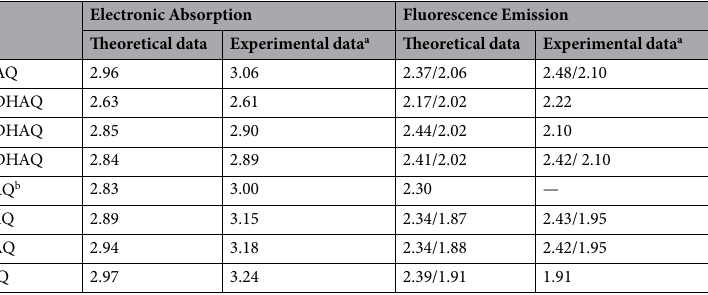
Table 2. Comparison of experimental and calculated absorbance and fluorescence emission band at the TDDFT/B3LYP /6–311 + G (d, p) level (unit is eV). a The experiment data was adapted from ref. 42 . b The data used for AAAQ is HAAQ (1-heptanoylamino AQ) to simplify